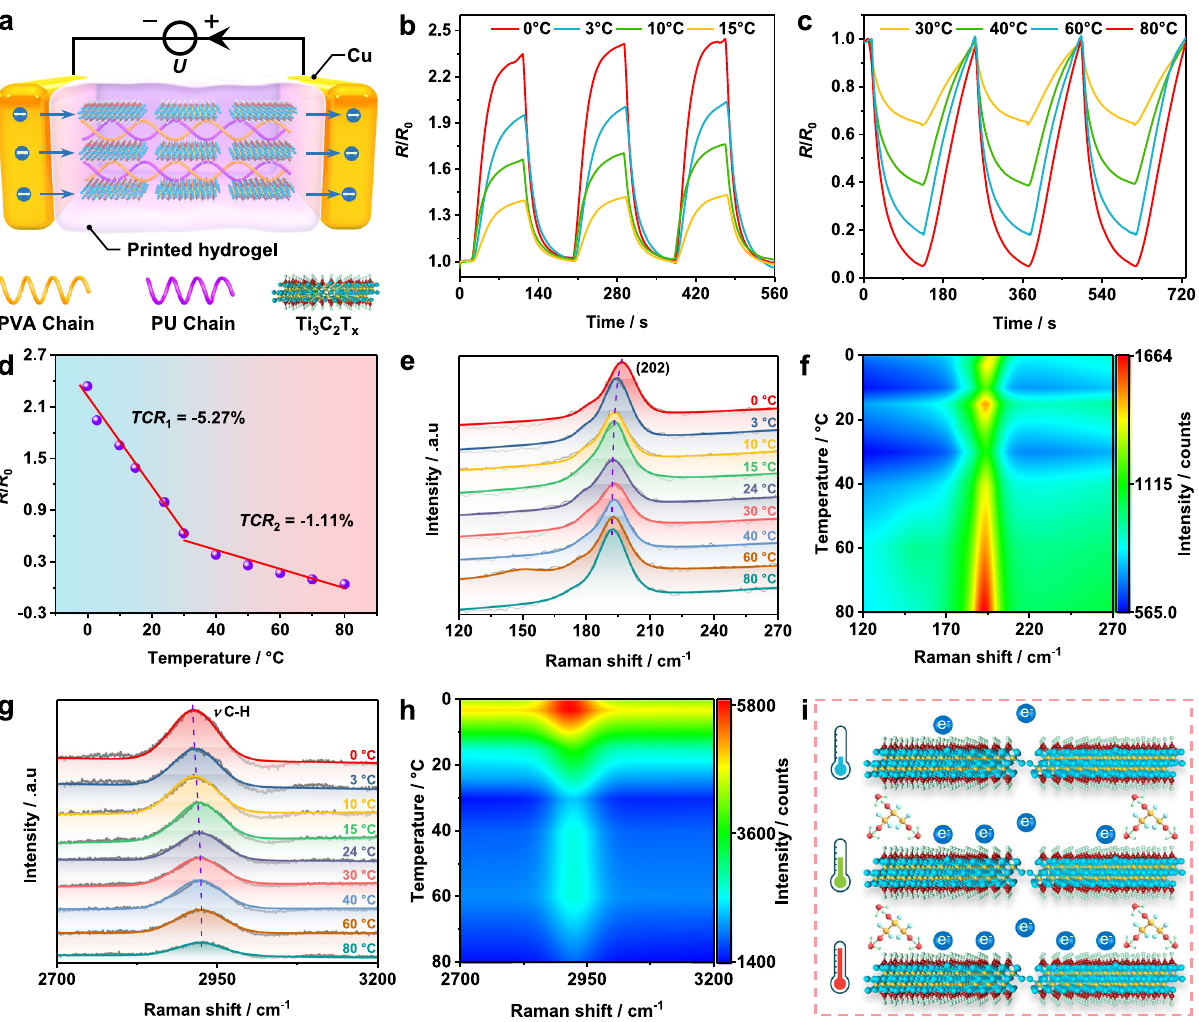
Fig. 4 Temperature responses of the printed sensor. a Schematic illustration of temperature sensing. b , c Resistance changes under different temperature (starting temperature: 24 °C), and ( d ) the resultant Temperature coef fi cient of resistance ( TCR ) for the sensor. Temperature-dependent Raman spectra of ( e , f ) Ti 3 C 2 T x and ( g , h ) printed thermistor. i Temperature sensing mechanism of the printed